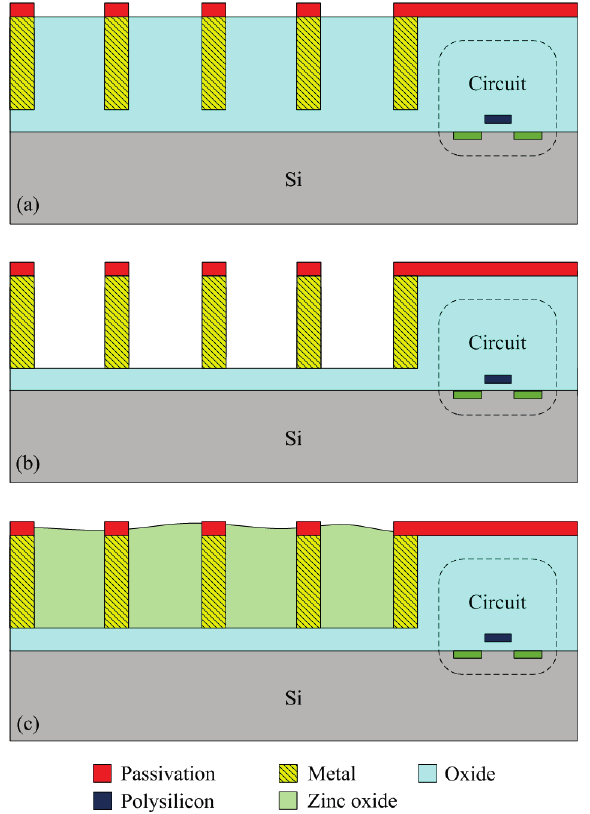
Figure 6. Process flow of the integrated humidity sensor, ( a ) after the CMOS